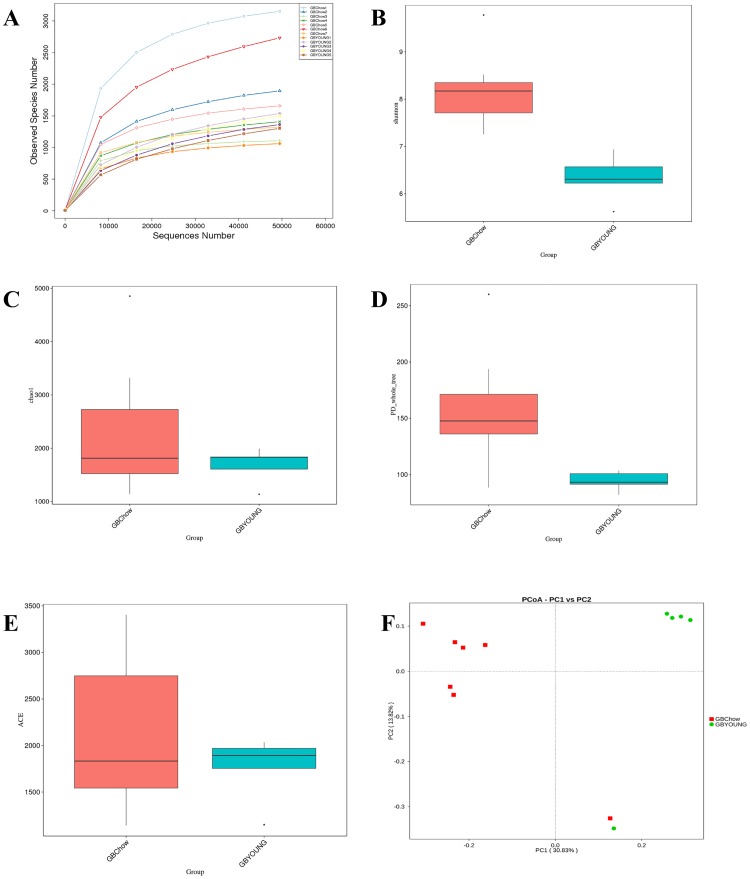
Measures of microbial diversity of gallbladder samples of the 2 age groups.A: Rarefaction curves (at 97% similarity level) of each gallbladder sample. B: Box plot of the Shannon-Weaver index. C: Box plot of the Chao-1 index. D: Box plot of phylogenetic diversity whole tree. E: Box plot of the ACE index. F: Unweighted UniFrac Principal Coordinate Analysis. GBChow: adult healthy rabbits; GBYOUNG: healthy rabbits before weaning.